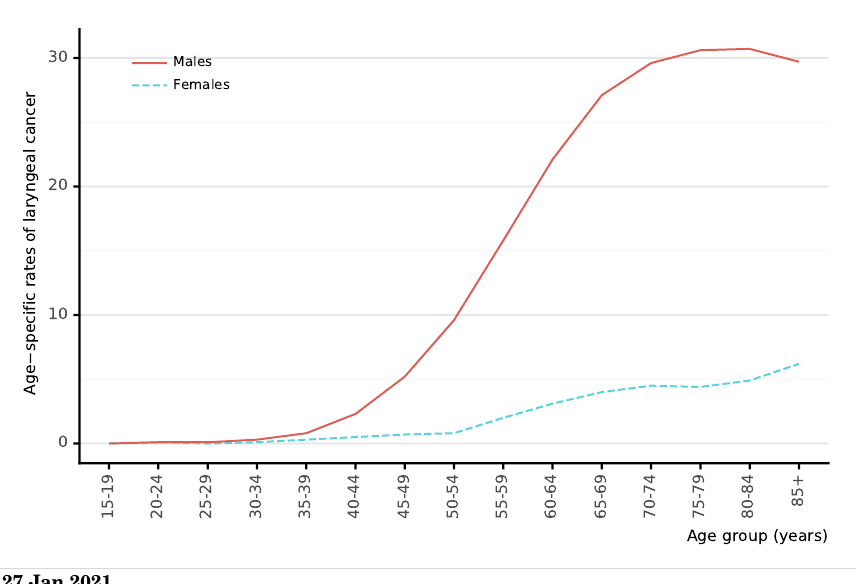
Figure 48: Age-specific incidence rates of laryngeal cancer in India (estimates for 2020)